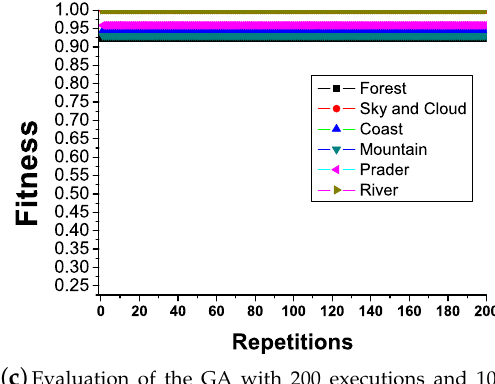
( c ) Evaluation of the GA with 200 executions and 100 generations per execution.